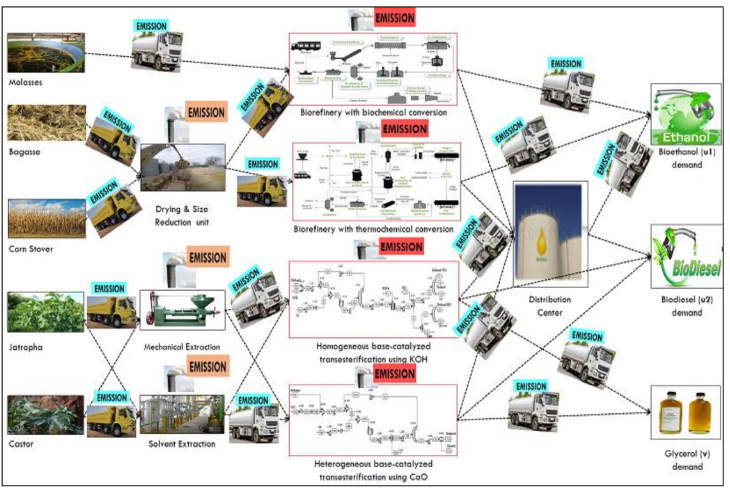
Figure 2. System boundary of LCA considered in this case study (solid black line indicates the